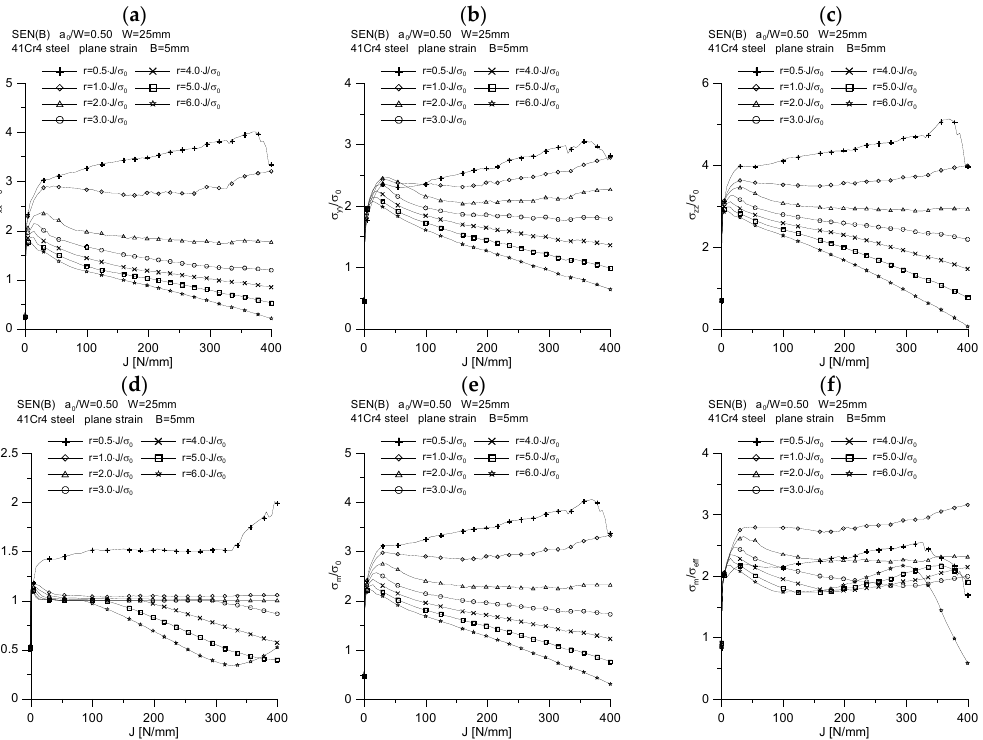
Figure 12. Influence of the external load and the normalized distance from the initial position of the crack tip on the distribution of the main components of the stress tensor ( a , b , c ), the distribution of effective stresses ( d ), mean stresses ( e ) and the ratio σ m / σ eff ( f ), for a SEN(B) specimen with a thickness of B = 5 mm, made of 41Cr4 steel.